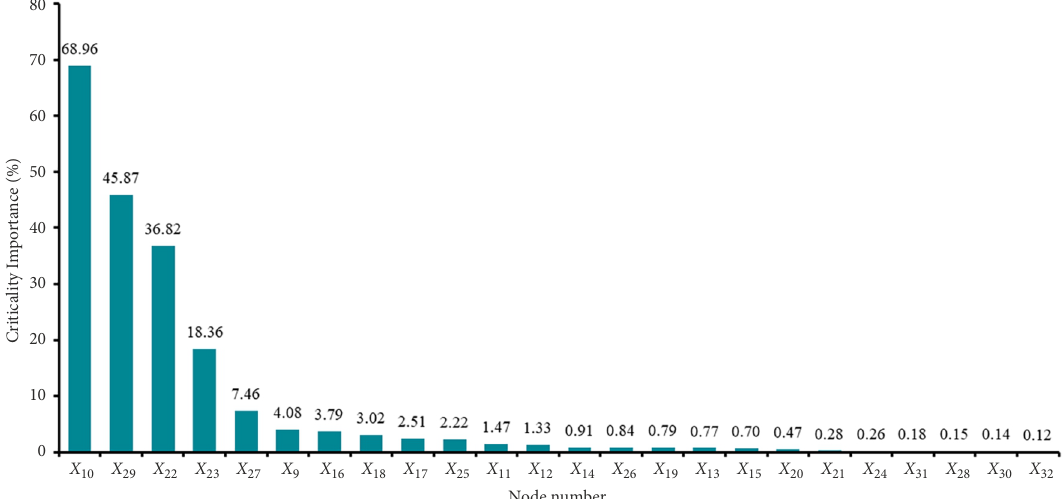
Figure 14. Sequencing results of Criticality Importance of nodes X 9 to X